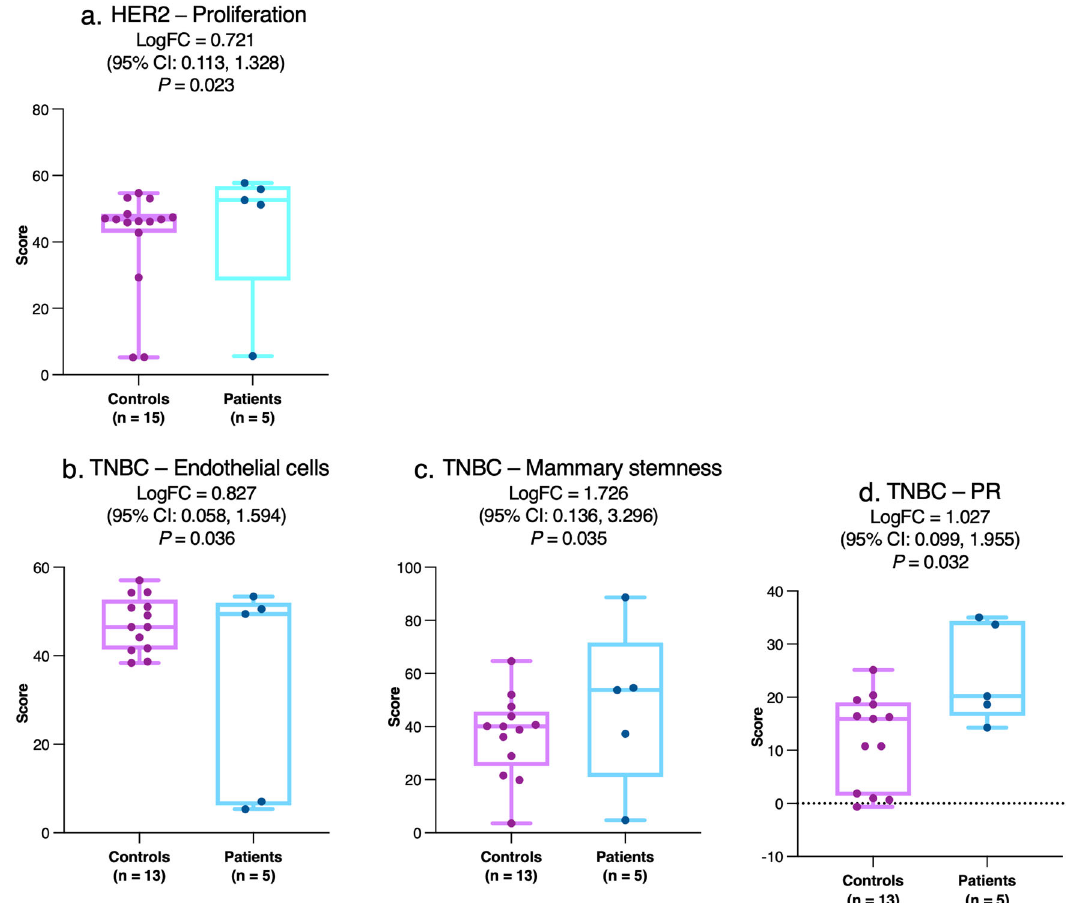
Fig. 4 Interindividual comparison of primary tumor gene expression between patients and matched controls with HER2-positive disease or TNBC. For the HER2 subgroup, data are shown for proliferation ( a ) while for the TNBC subgroup, data are shown for endothelial cell activation ( b ), mammary stemness ( c ), and progesterone receptor ( d ). The central line indicates the median, the box indicates the 25th and 75th percentiles and the whiskers indicate the range. Circles represent individual data points. Negative values for logFC indicate lower expression in patients with relapse versus controls. Abbreviations: CI con fi dence interval, HER2 human epidermal growth factor receptor 2, logFC log 2 -fold change, PR progesterone receptor, TNBC triple-negative breast